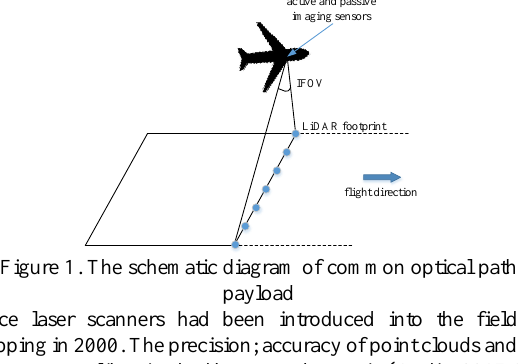
Figure 1. The schematic diagram of common optical path